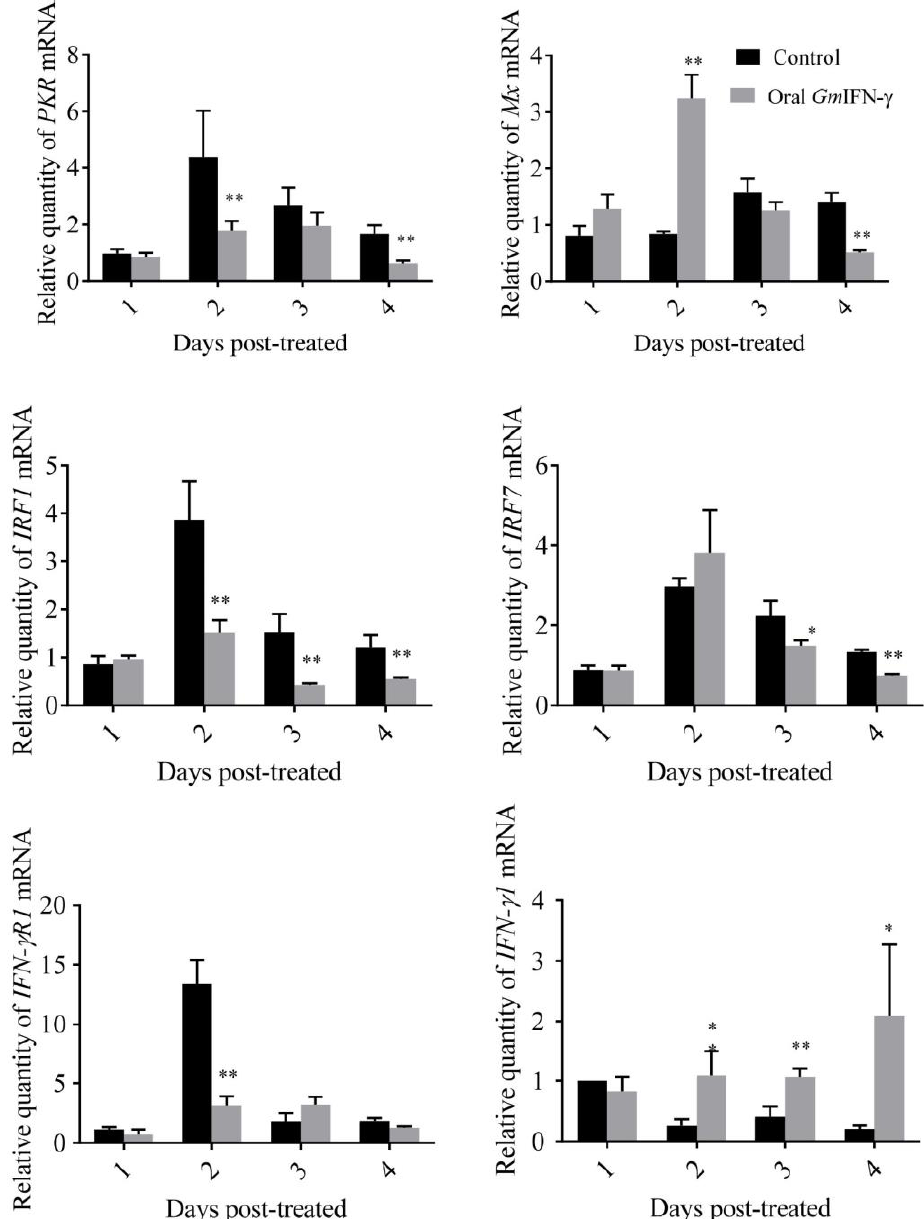
Figure 7. Expression levels of genes related to the IFN–I signal pathway of zebrafish fed with yeast containing GmIFN– γ . T tests were used for statistical analysis. * indicates significant differences ( p < 0.05), while ** indicates strong significant differences ( p < 0.01).